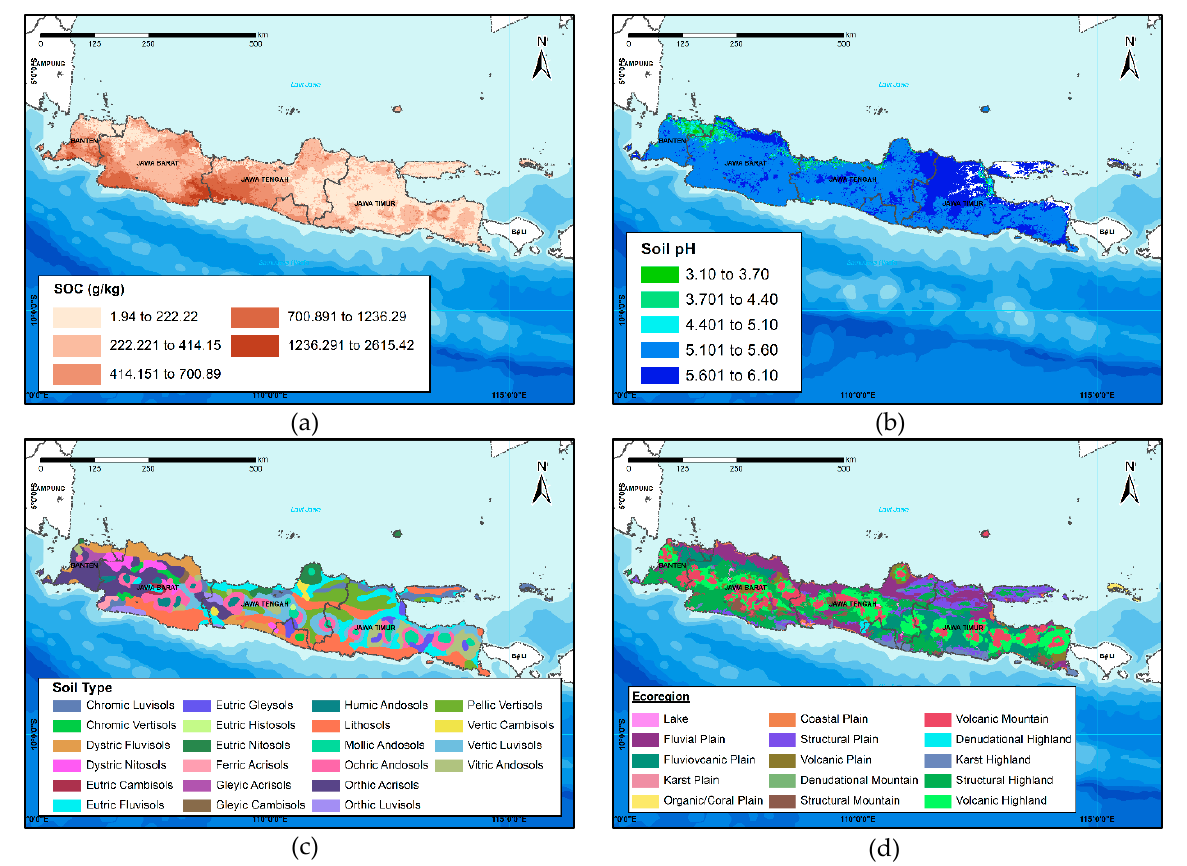
Figure 4. The soil characteristics: soil organic carbon (SOC) ( a ), soil pH ( b ), soil type ( c ), and ecoregion ( d ).